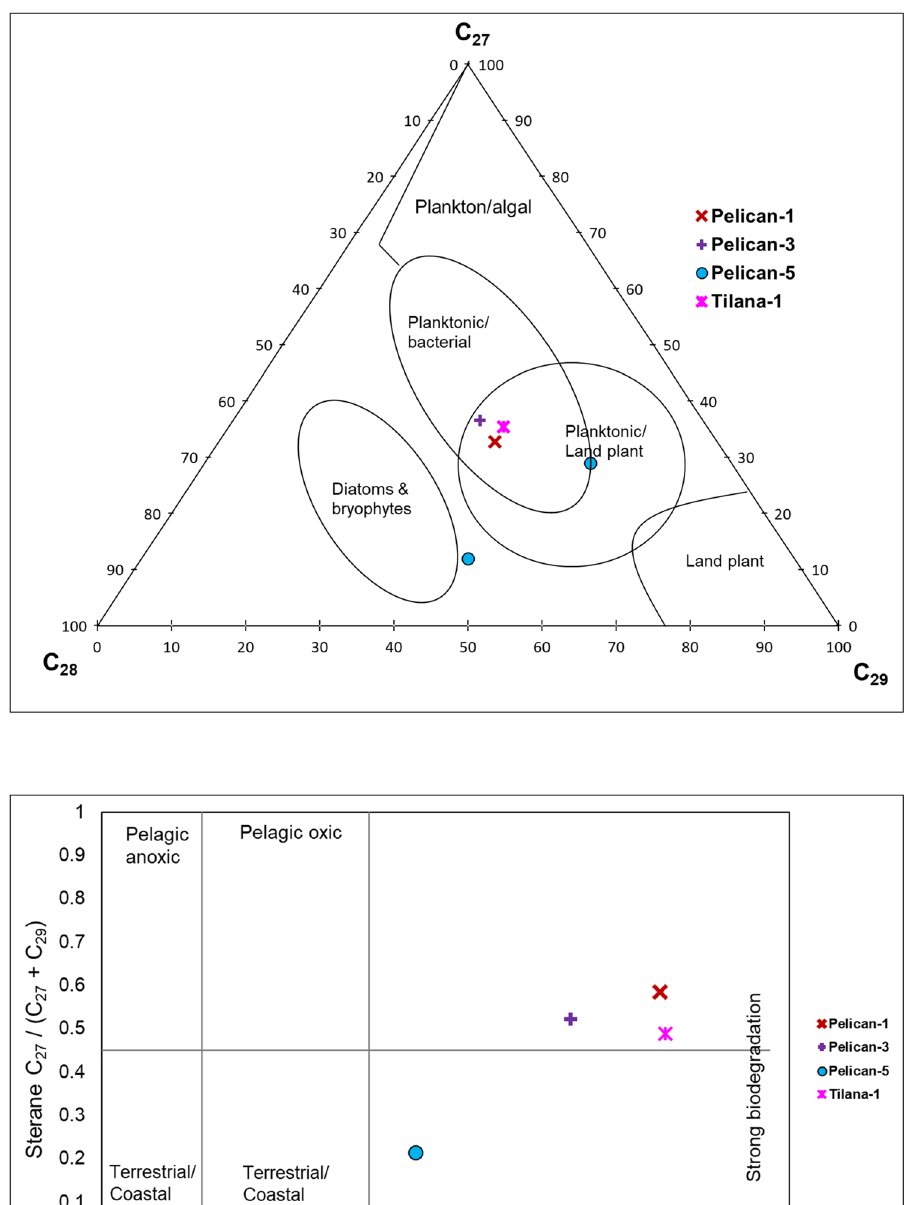
Fig. 15 Ternary diagram of the regular steranes C 27 , C 28 and C 29 for paleodepositional envi- ronment of the Narimba Forma- tion (modified from Huang and Meinschein 1979)